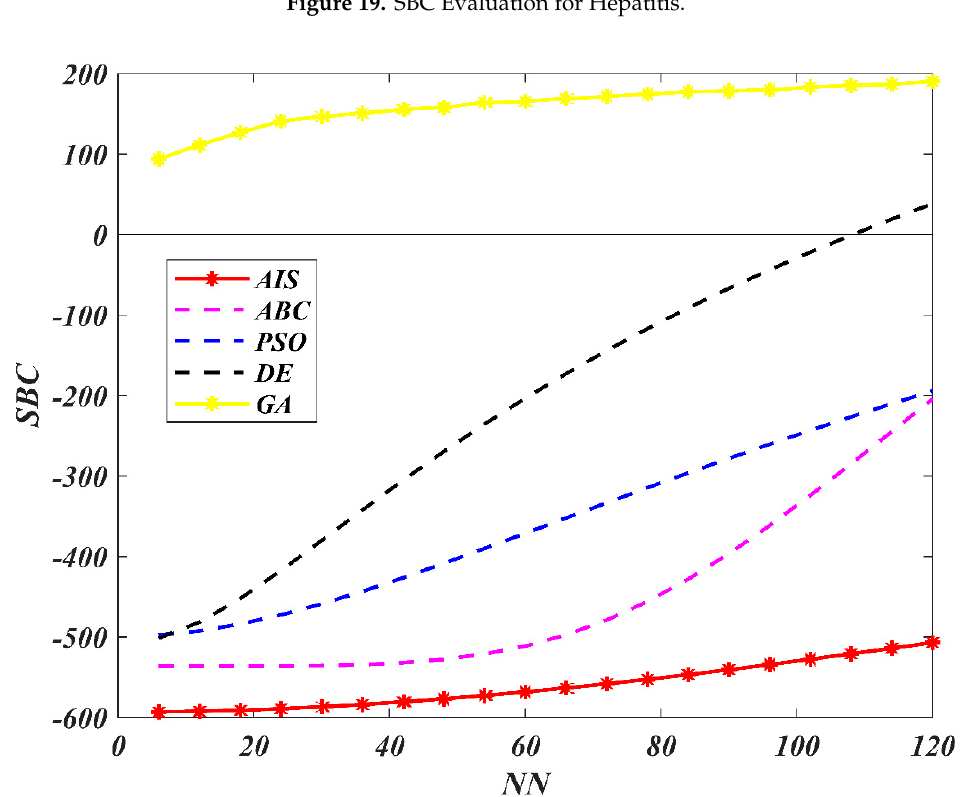
Figure 19. SBC Evaluation for Hepatitis.